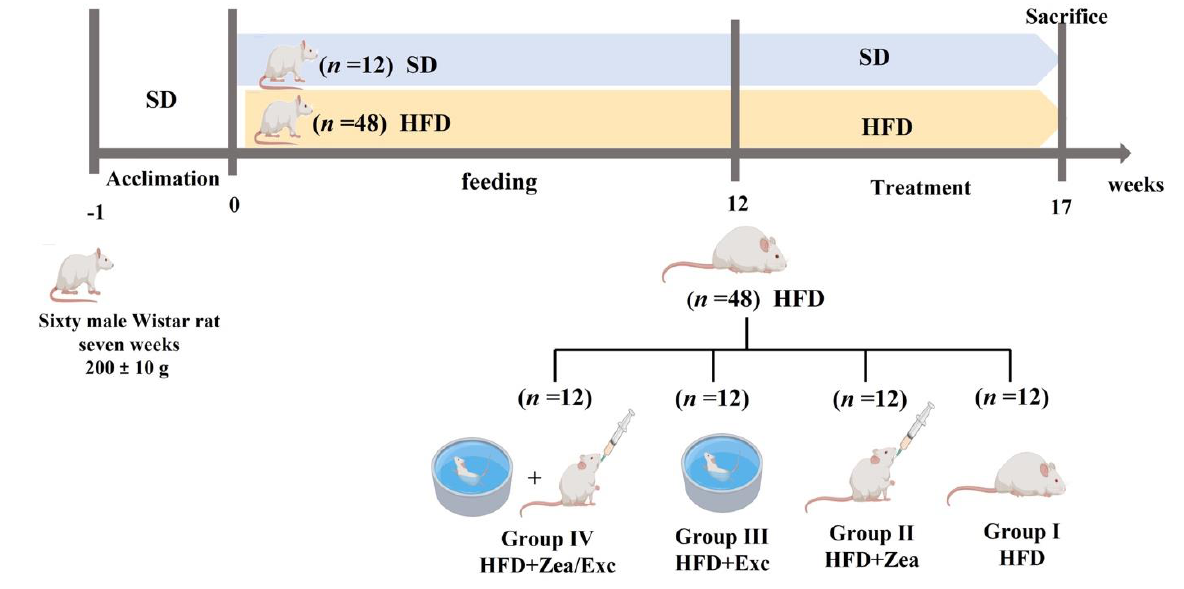
Figure 1. Experimental design.